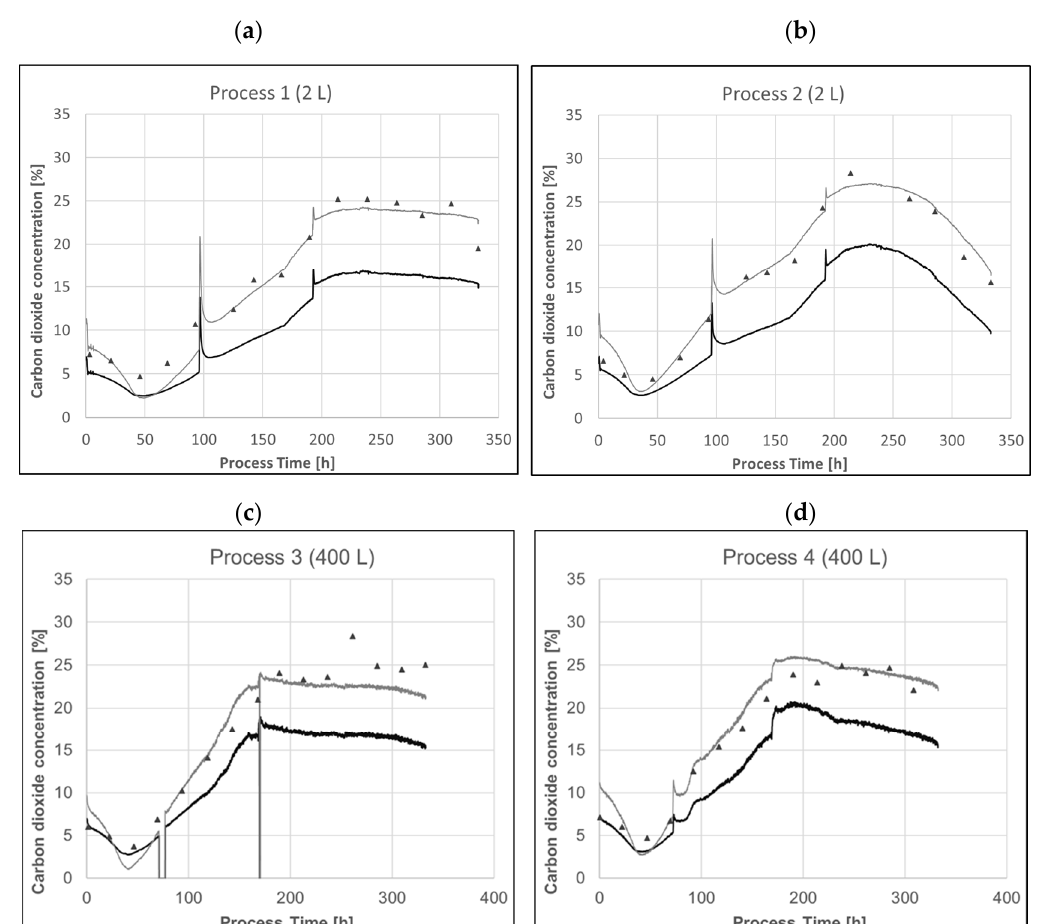
Figure 9. ( a , b ) Profiles of raw exhaust CO 2 concentration (black line), predicted pCO 2 concentration using Equation (1) with a sample hold time of 3 min ( a ) or 4.5 min ( b ) (grey line) and the sample-based pCO 2 measurement (black triangles) of a representative process in a 2 L system. ( c , d ) Profiles of exhaust CO 2 concentration (black line), of predicted pCO 2 concentration using Equation (1) with a sample hold time of 1 min (grey line) of a representative process in a 400 L system. The model was derived from 2 L data and directly applied to 400 L. All bioreactors were pressure controlled at 400 mbar overpressure.